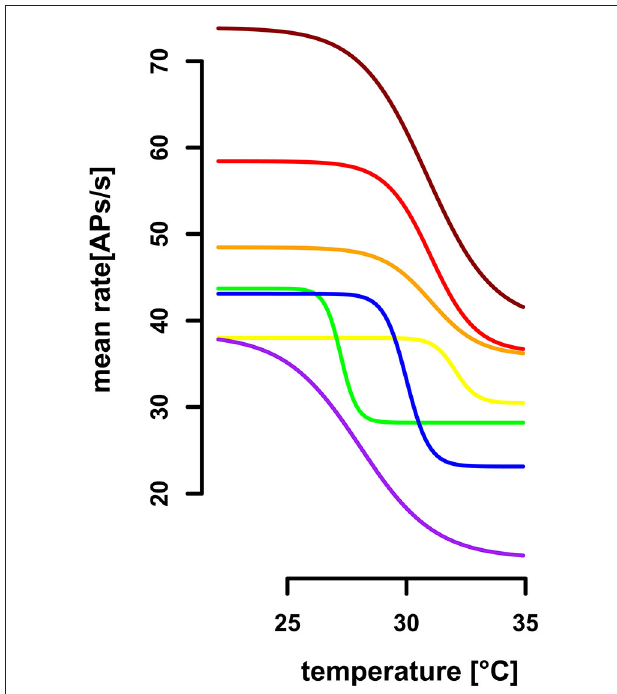
FIGURE 7 | Extrapolated dose-response curves for seven ST-neurons. Sigmoidal regressions were calculated for seven ST-neurons (color-coded), based on their activity profile during gradual temperature increase. The working range of ST-neurons was between 26.87 ◦ C ( SD = 2.51, range: 22.4 ◦ C–30.5 ◦ C) and 33.2 ◦ C ( SD = 2.47, range: 28.4 ◦ C − 35.9 ◦ C). The highest differential sensitivity (slopes at the turning points) range from 3.08AP/ ◦ C to 11.49AP/ ◦ C ( SD = 3.29, mean: − 6.48AP/ ◦